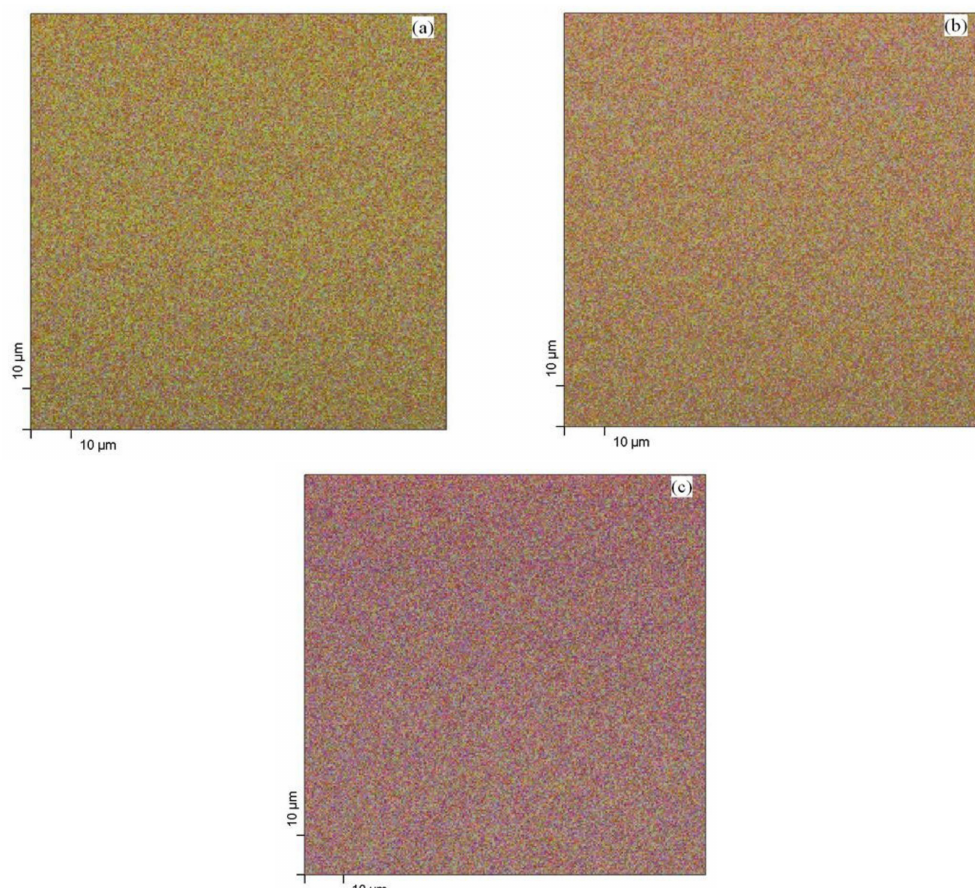
Figure 6. The RGB overlay of O, Ti and Zn distribution in samples: ( a ) TZN_30, ( b ) TZN_60 and ( c ) TZN_90. Uniform distribution of the atomic species is shown on a macroscopic scale in all the images in Figure 6, which is sustained by the results shown in Figure 7, where RGB scans were plotted across the chemical maps, with the color coding mentioned previously. The digital images of the XPS chemical mapping were processed by using the Color Profiler plugin of the ImageJ package. Nearly constant values of the oxygen signal is present in all the samples, while the zinc signal increases gradually with the deposition time (and, consequently, the ZnO coverage) at the expense of the titanium signal (green color). This evolution is due to the specific probing depth of the XPS analysis (5–10 nm).